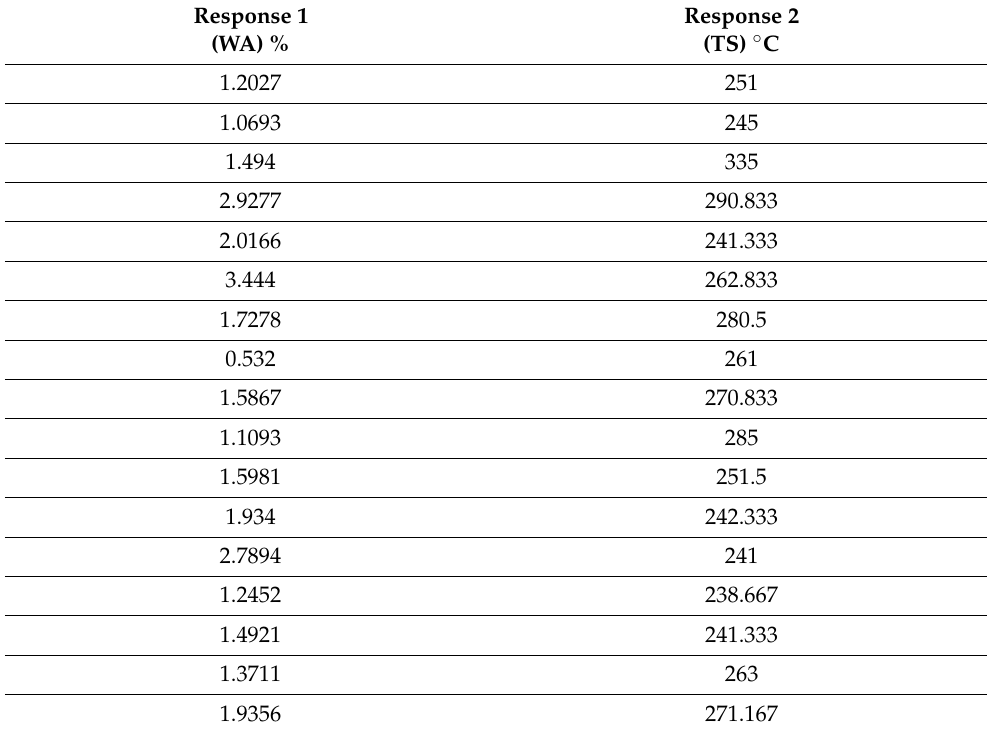
Table 2. Box-Benken experimental design responses for bioplastic